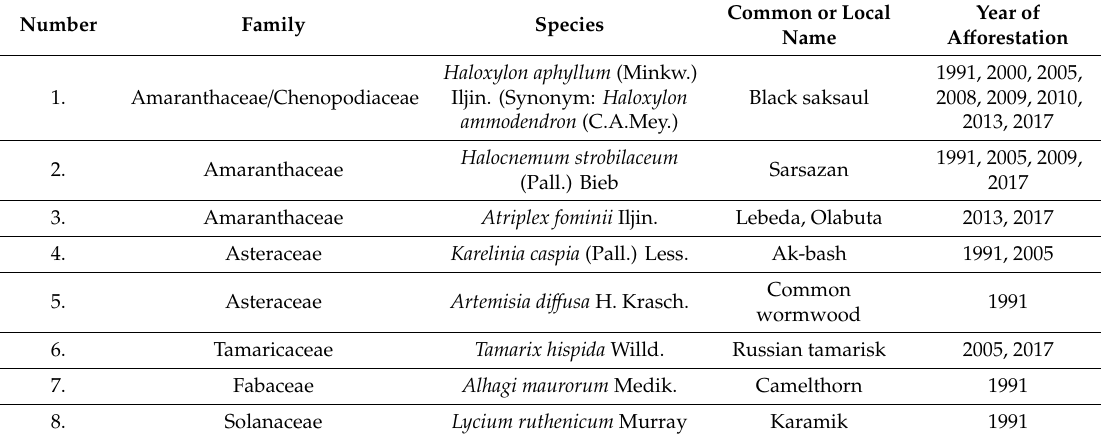
Table 1. Plant species identified in August 2018 in the northern Aralkum sites a ff orested with Haloxylon aphyllum during 1991–2017 (plantations aged 1–27